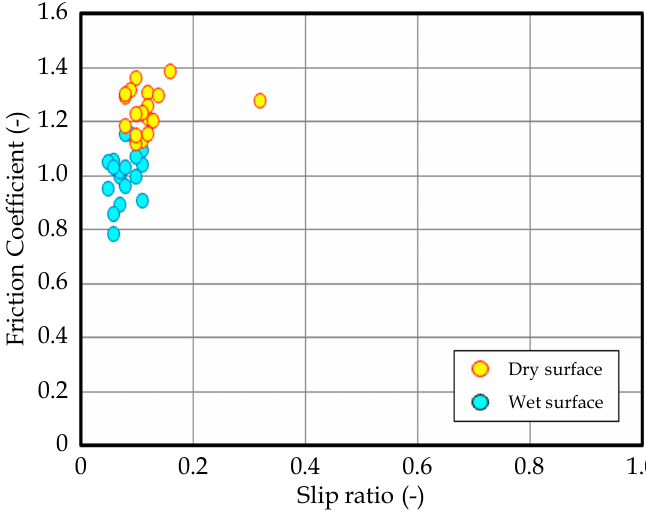
Figure 7. Measurement result for road friction with the Grip Tester.